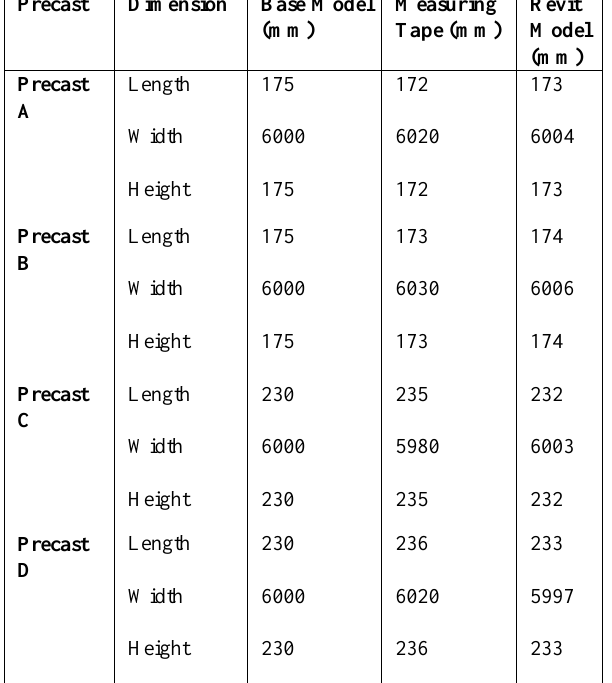
Table 2. Result of dimensional measurement